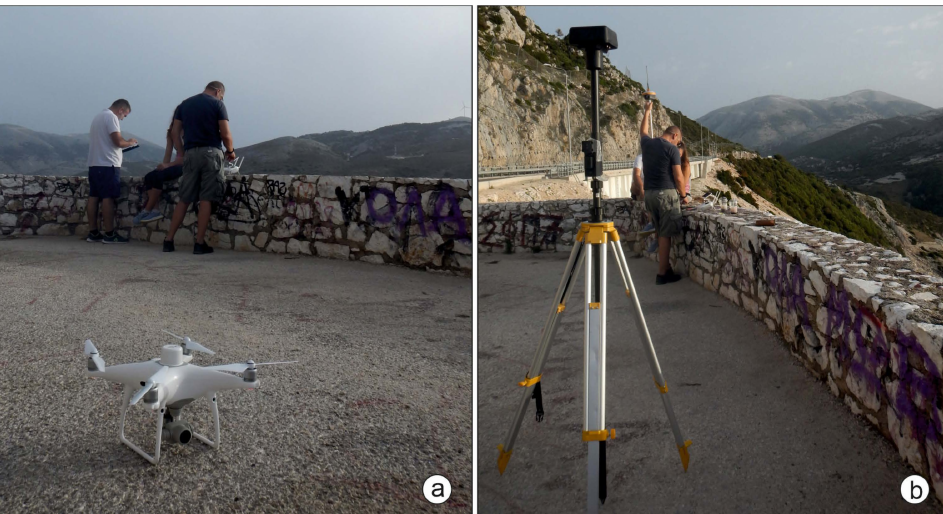
Figure 7. Views of the equipment used for detecting the geomorphological changes triggered by the 2020 Medicane Ianos in the Myrtos coastal area: ( a ) a commercial multi-rotary UAS (DJI Phantom 4 RTK) with an on-board GNSS antenna with the ability of RTK processing was used as a rover antenna, ( b ) the DJI D-RTK-2 was used as the base station